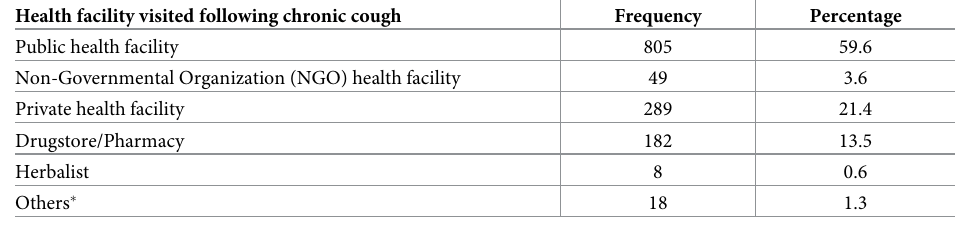
Table 2. Table showing health facilities initially visited by patients with chronic cough (n =